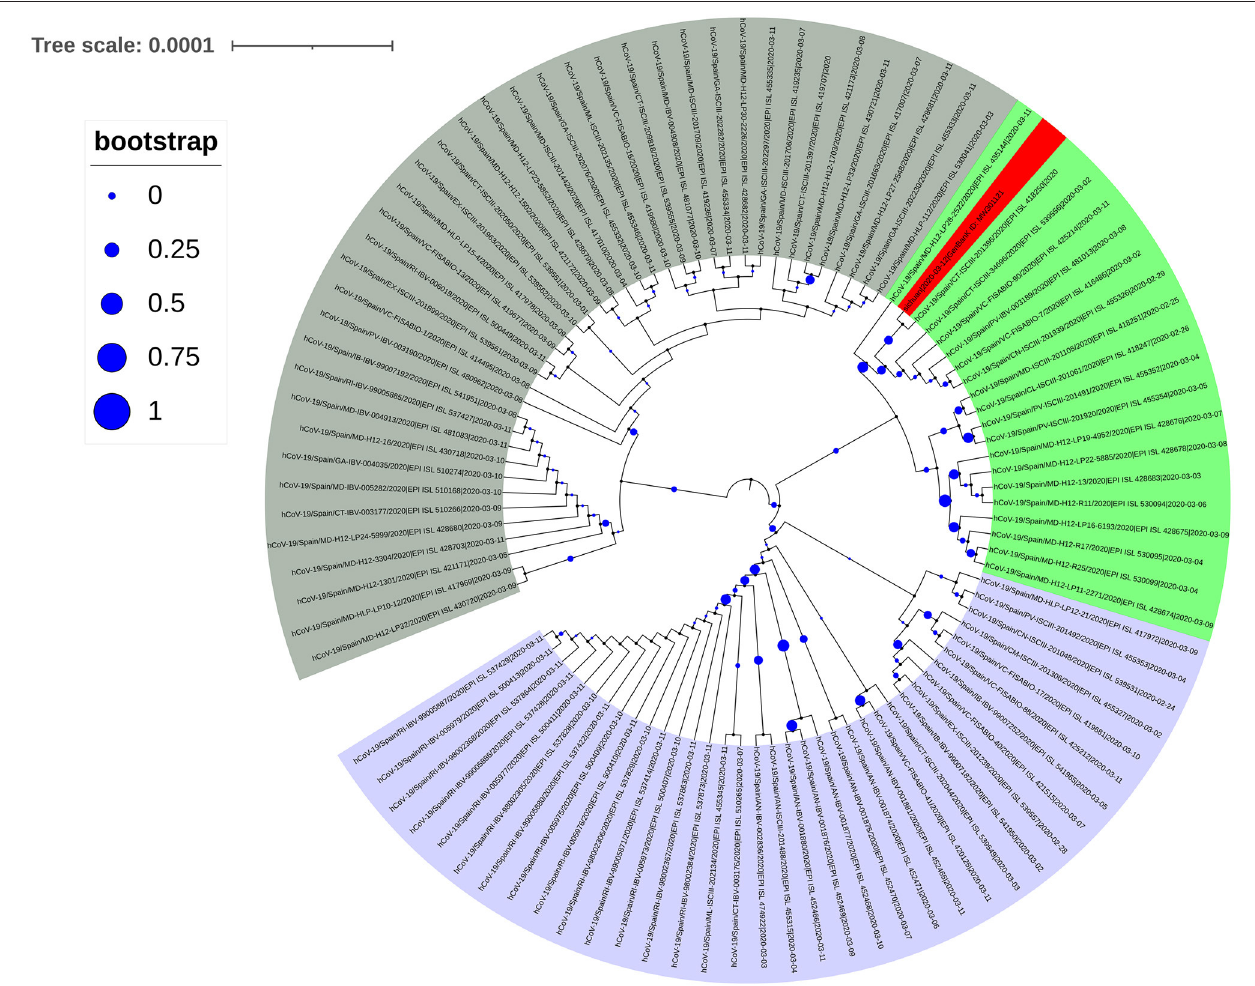
FIGURE 3 | Phylogenetic tree of the SARS-CoV-2 spike protein sequence with the D614G mutation collected in Spain before March 11, 2020. The next-generation sequencing sequence (Gene Bank ID: MW301121) was stained red. P323L mutation has been reported to co-evolve with